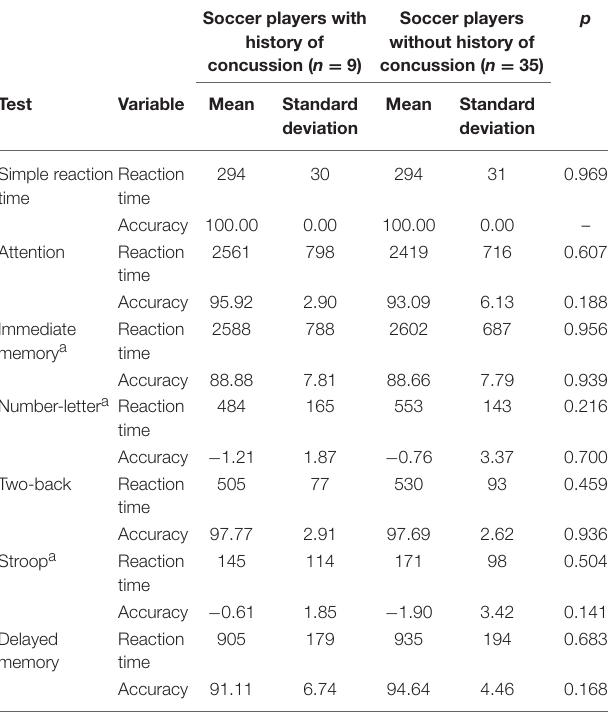
TABLE 6 | Correlations between performance of soccer players on computerized cognitive assessment and estimate of exposure to heading during professional soccer career.